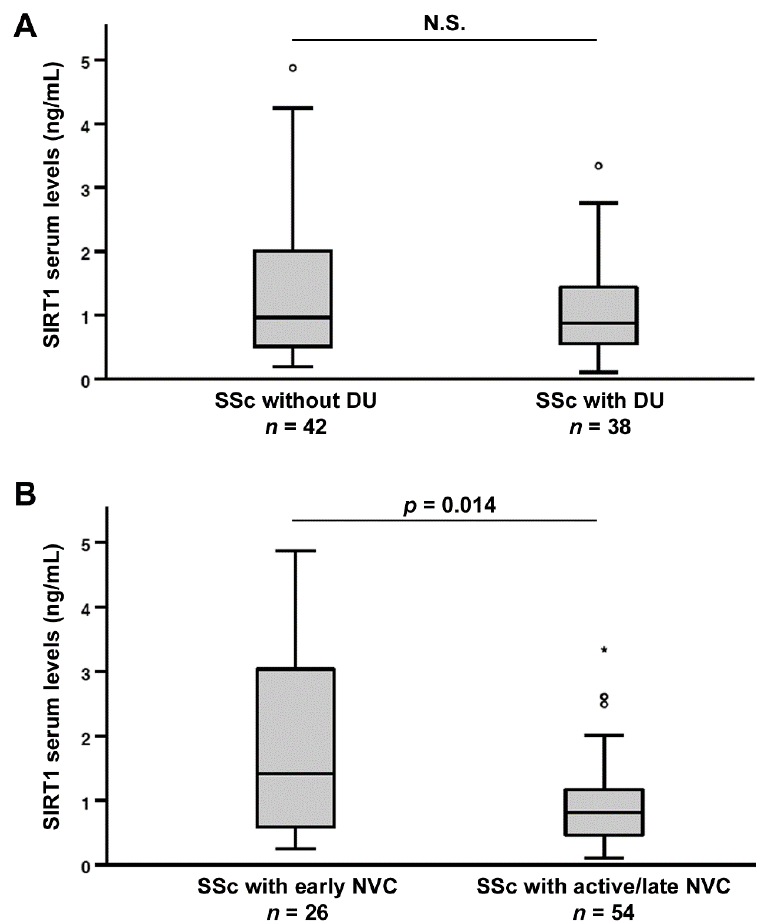
Figure 3. Association of serum sirtuin 1 (SIRT1) levels with the severity of peripheral microvascular damage in systemic sclerosis (SSc) patients. ( A ) SIRT1 levels in SSc patients with and without ischemic digital ulcers (DUs). ( B ) SIRT1 levels in SSc patients stratified according to “early” and “active/late” nailfold videocapillaroscopy (NVC) patterns. Data are presented as box plots. Each box denotes the 25th to 75th percentiles. Lines outside the boxes are the 10th and 90th percentiles. Lines inside the boxes denote the median, circles denote the outliers, and asterisks denote the extreme values; p values are indicated. N.S., not significant.